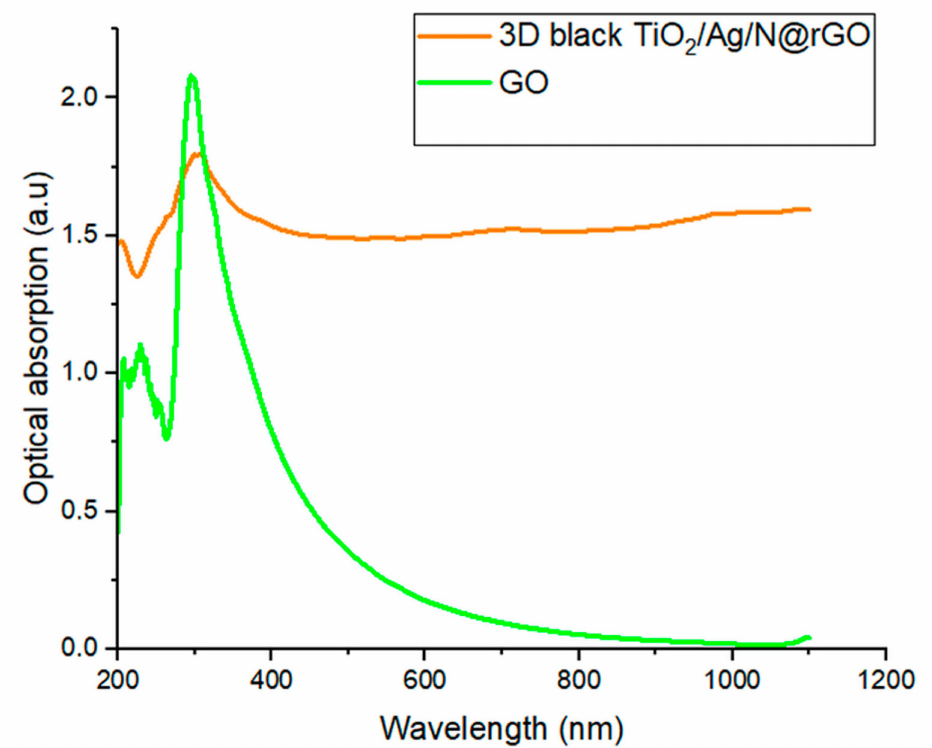
Figure 8. Broadband UV-Vis NIR absorption spectra for 3D black TiO 2 /Ag/N@rGO (orange colour) and GO (green colour)